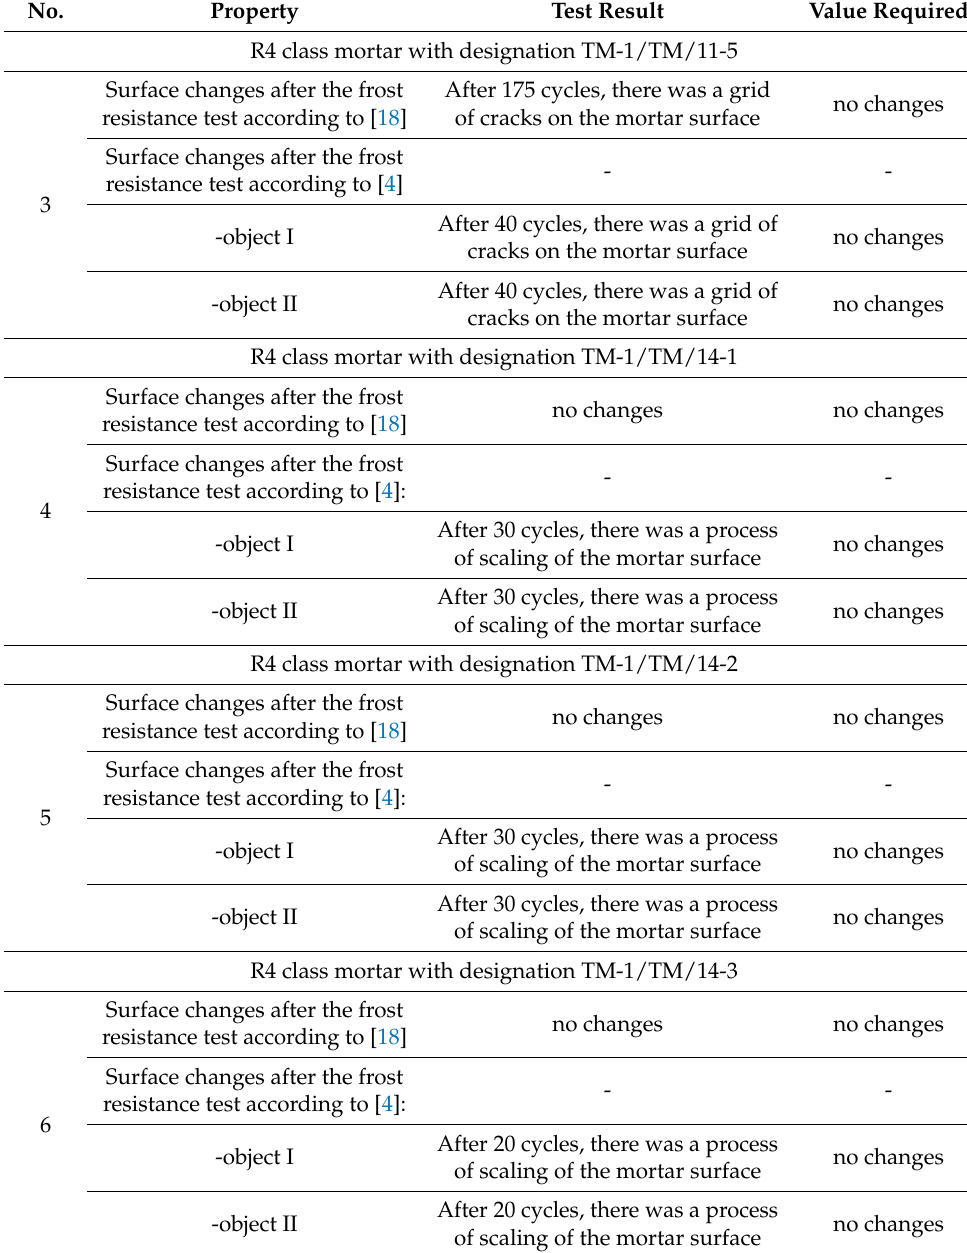
Table 3. Cont. No. Property Test Result Value